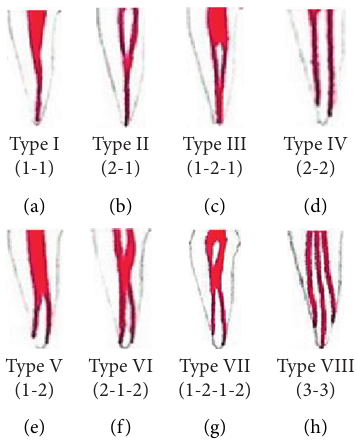
Figure 1: Weine’s classification of root canal morphology from type I to type IV.